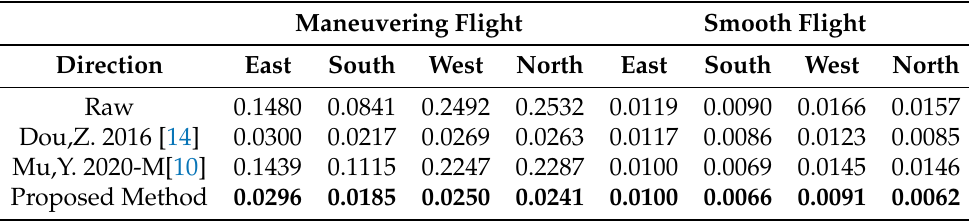
Table 2. The comparison of standard deviations σ (the lower, the better) by the three